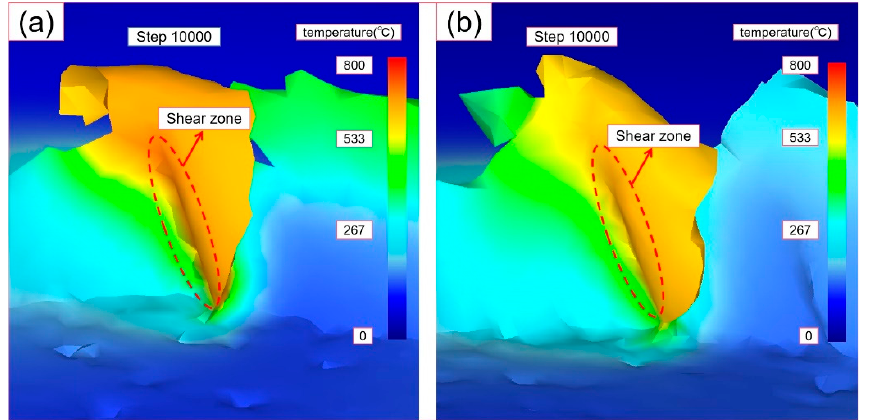
Figure 7. Distribution of cutting temperature field ( a ): TMM ( V c = 37.7 m/min; ƒ z = 6 μ m/z; A = 0 um); ( b ): UVAMM ( V c = 37.7 m/min ; ƒ z = 6 μ m/z; A = 6 um).